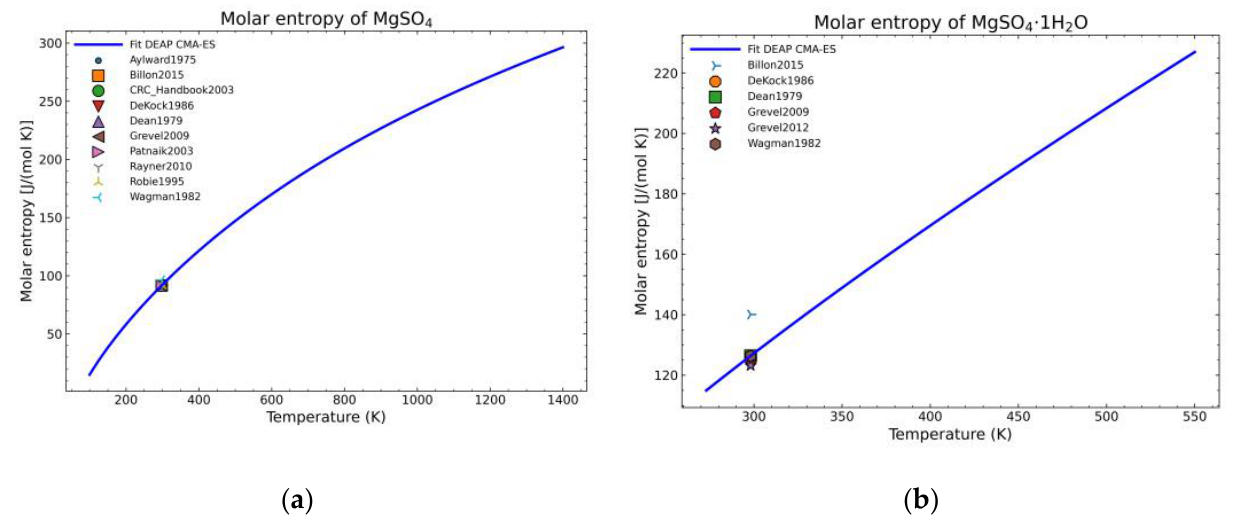
Figure 16. Fitted results of the entropy curve in the literature points region for: ( a ) MgSO 4 ; ( b ) MgSO 4 · 1H 2 O. The enthalpy and entropy data were also statistically analyzed. The results